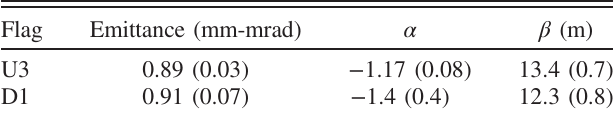
TABLE III. Comparison of single bunch emittance measure- ment on screen U3 and D1.